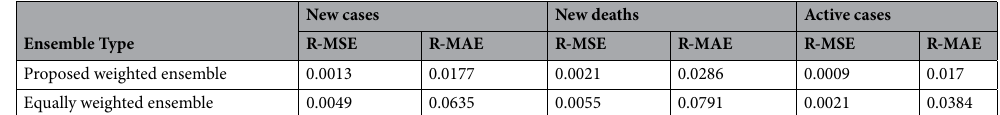
Table 5. Comparison of results for Spain-Bangladesh model (with fine-tuning), using the proposed weighted ensemble and equally weighted ensemble.